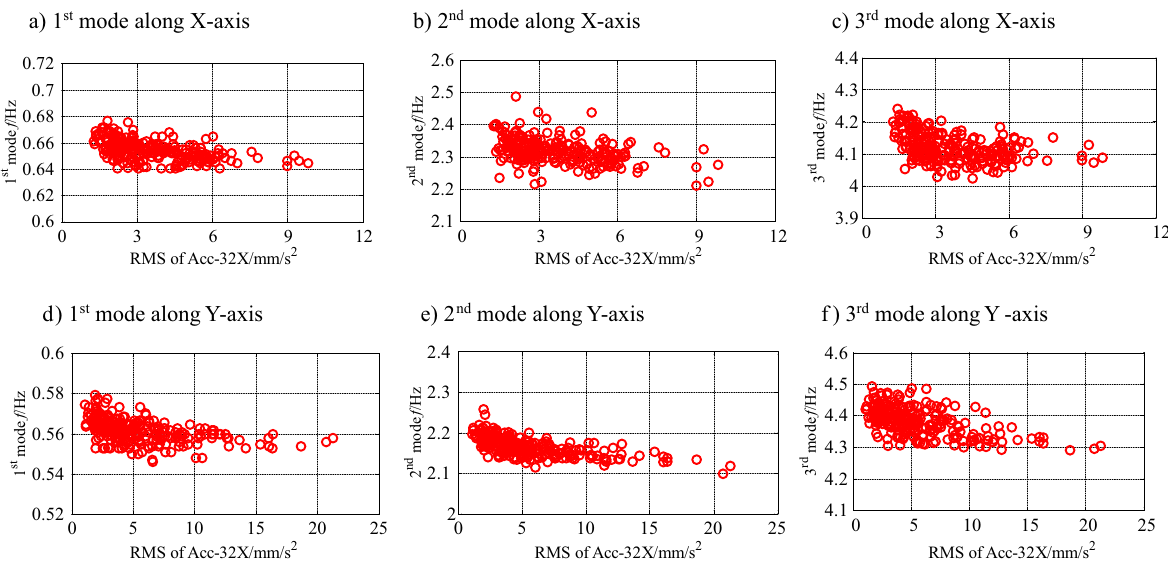
Figure 16. The relationship between modal frequency and RMS of Acc at the top floor